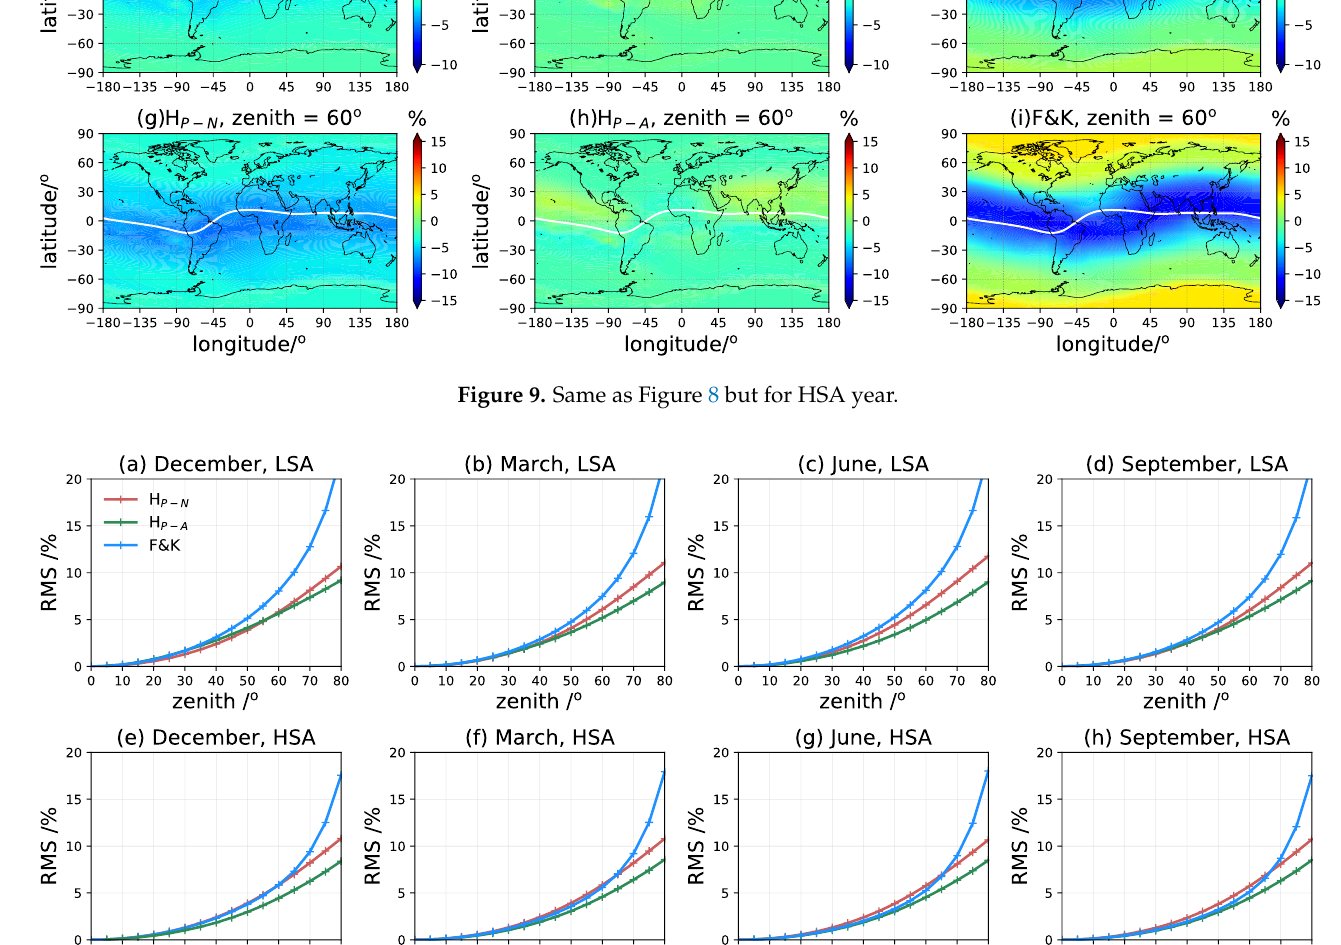
Figure 10. Same as Figure 5 but for LEO satellite at 500 km.